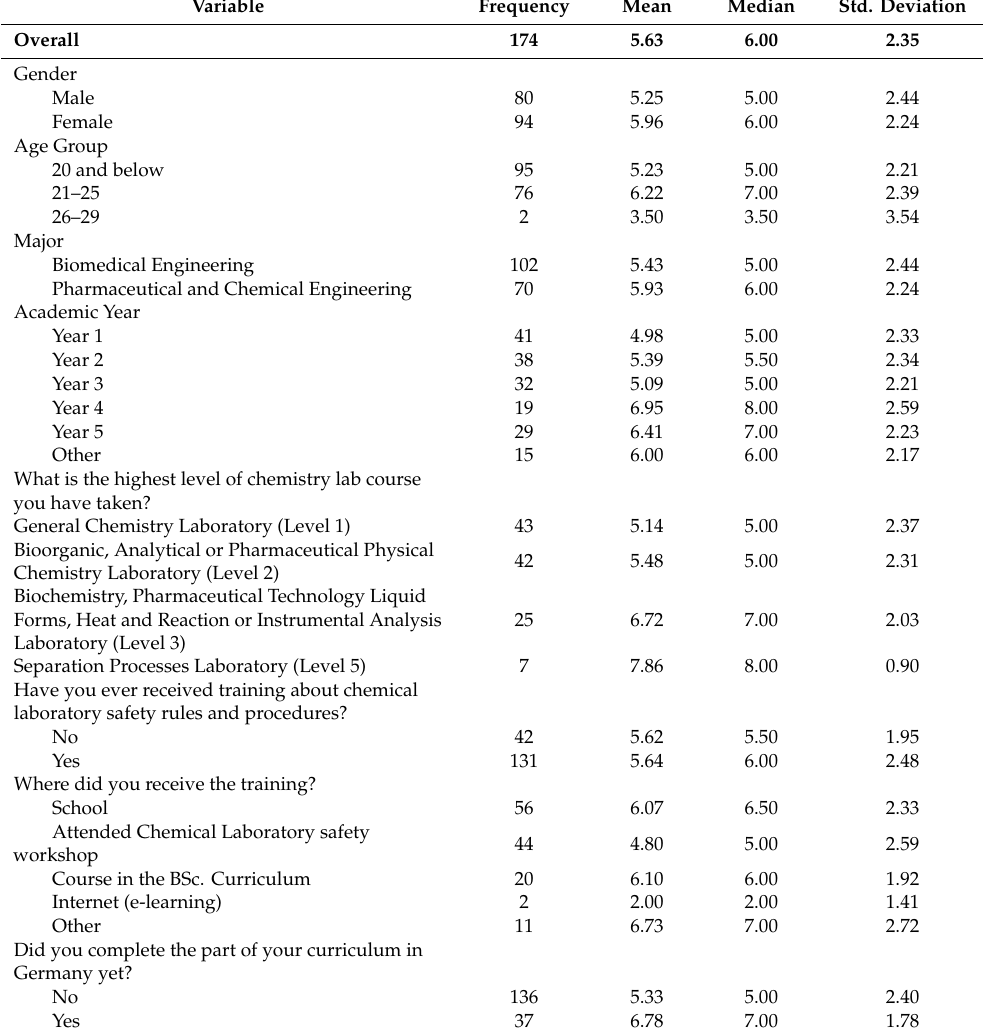
Table 2. Descriptive statistics for the knowledge scores by selected